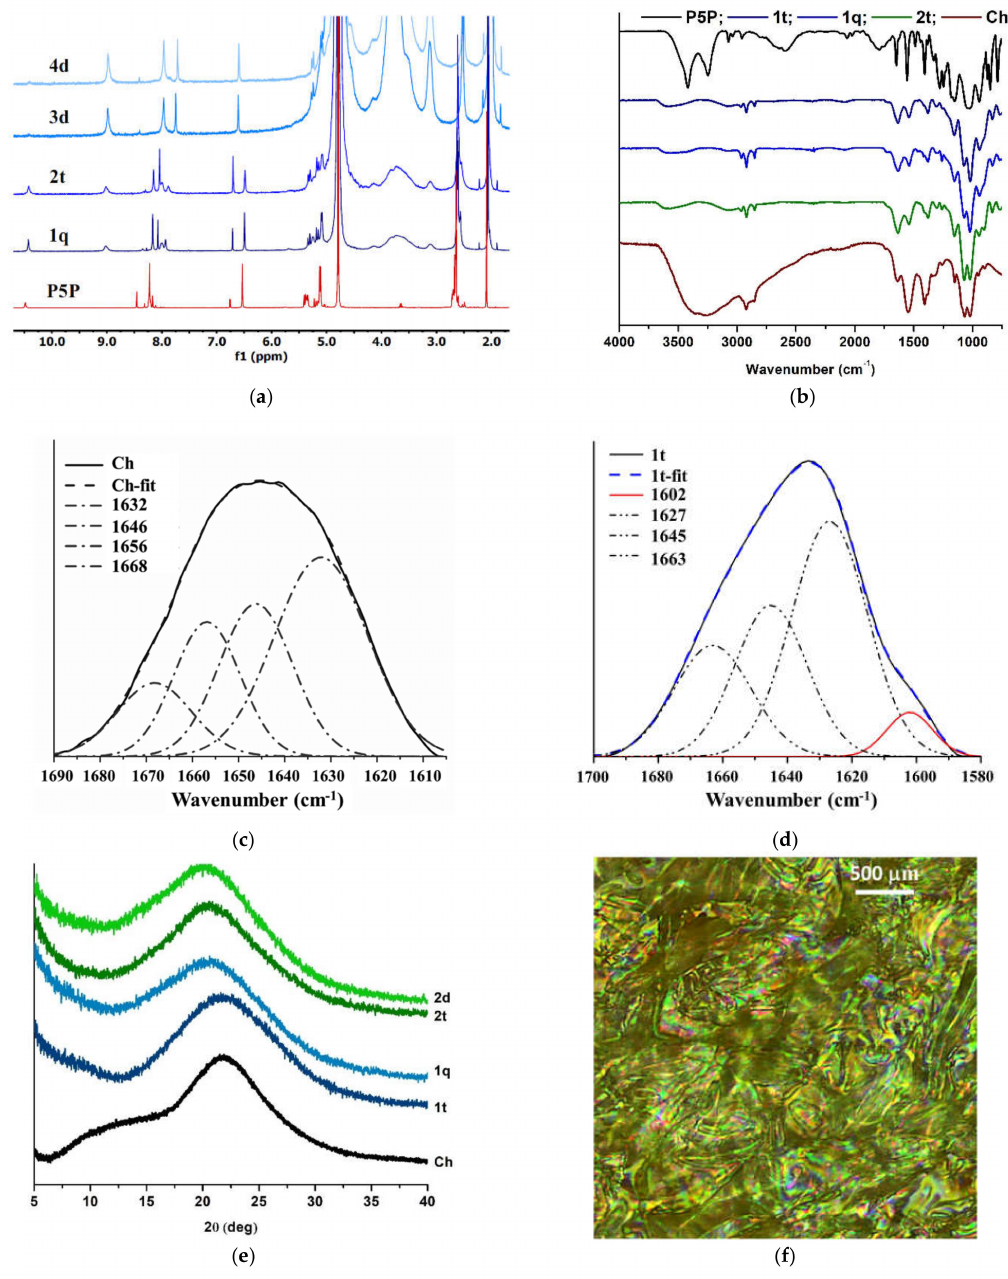
Figure 1. ( a ) NMR spectra of representative hydrogels and pristine aldehyde; ( b ) FTIR spectra of repre- sentative xerogels compared to pristine aldehyde and chitosan; ( c , d ) deconvolution of 1580–1700 cm − 1 domain for chitosan and 1t hydrogel; ( e ) X-ray diffractograms of representative xerogels and pristine chitosan; ( f ) Representative POM image of xerogel 1.5t (to be representative, the hydrogels given in figure have different molar ratio of glucosamine/aldehyde units and/or different water